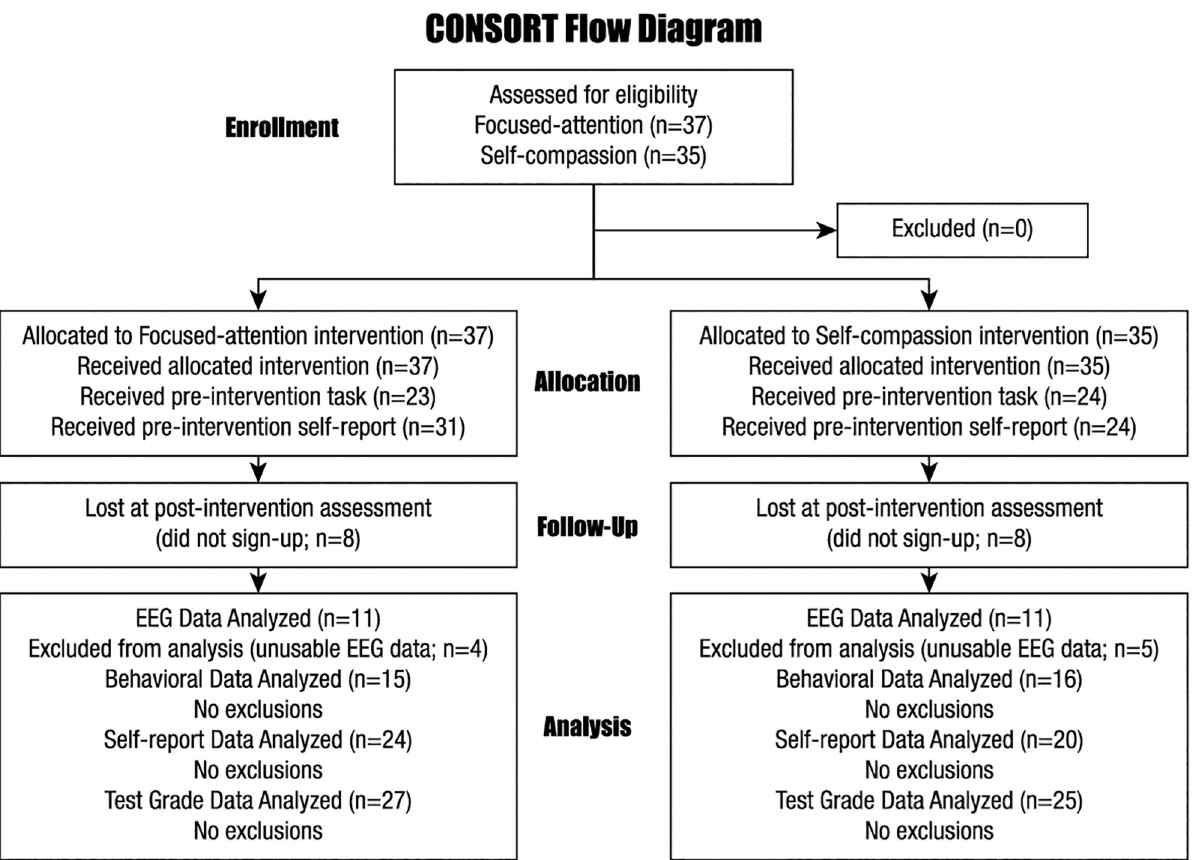
Fig 1. Consort flow diagram indicating inclusion and participation of participants at different stages of the